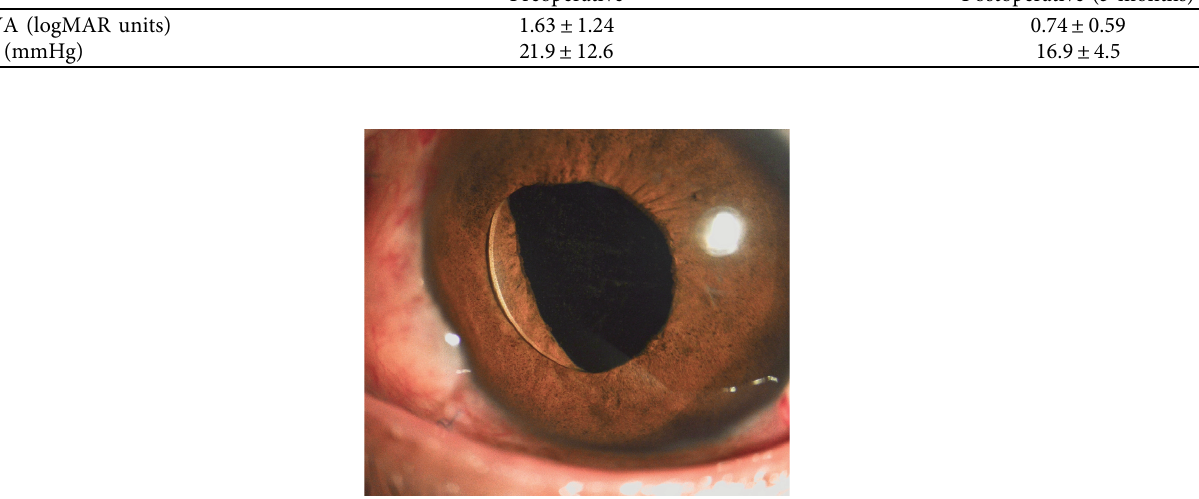
Figure 6: Photography of pupillary